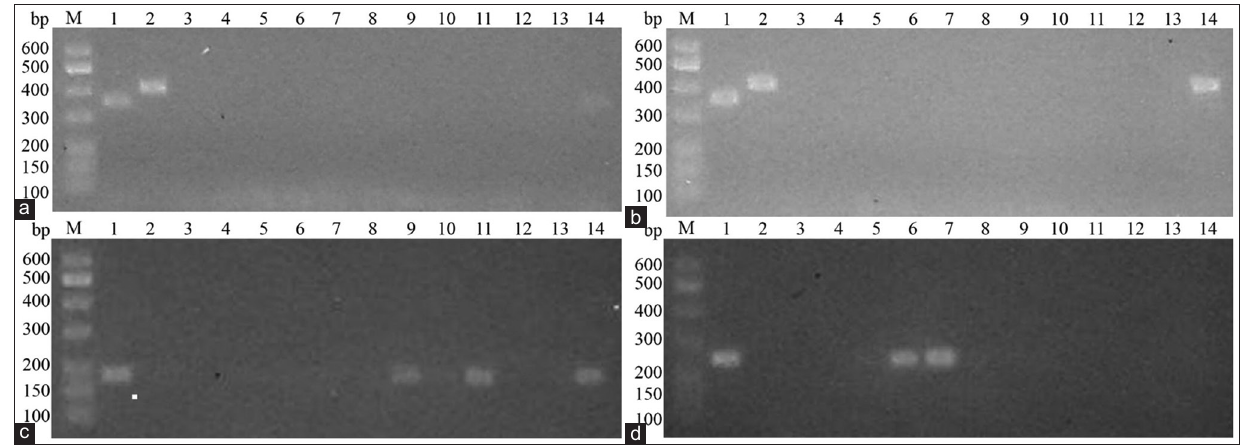
Figure-2: Example of polymerase chain reaction gels of (a) Babesia canis amplicons at 356 bp (b) Hepatozoon canis amplicons at 409 bp (a and b, Lane 1 = B. canis positive control, Lane 2 = H. canis positive control, Lanes 3-14 = samples). (c) Example of Ehrlichia canis amplicons at 181 bp and (d) Anaplasma platys amplicons at 250 bp (c and d, Lane 1 = positive control, Lanes 2-14 = samples). Corresponding lane numbers between figures (a-d) are not related to the same Table-2: Comparison between blood smear and PCR techniques regarding the prevalence of tick-borne pathogens infection among dogs. Pathogen/ techniques